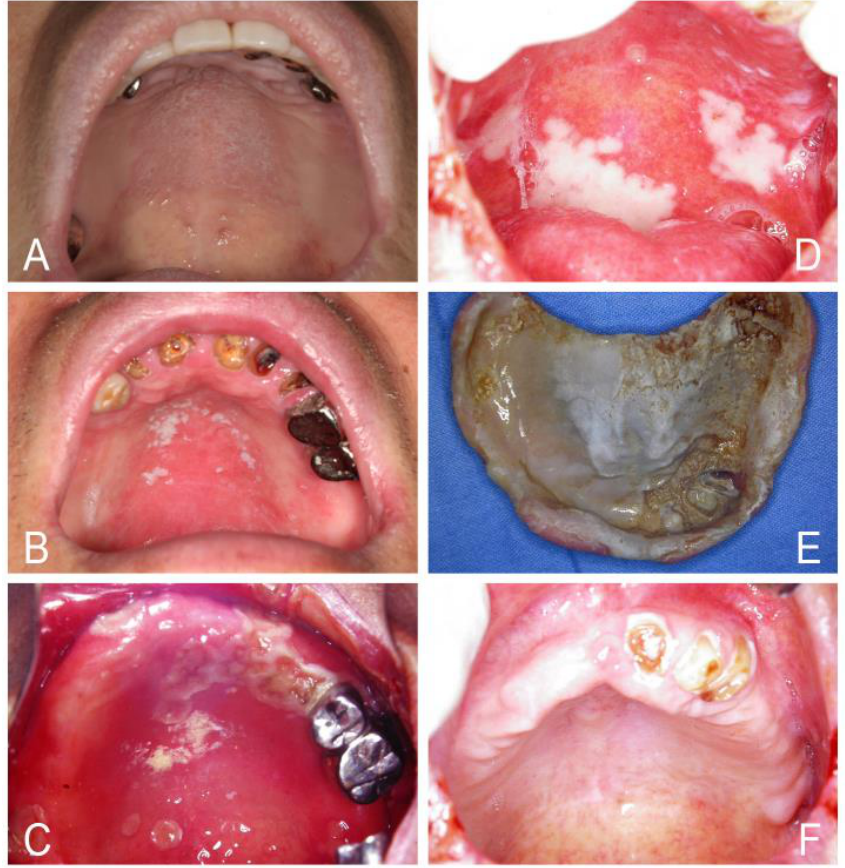
Figure 4. Candida -associated denture stomatitis ( A – D ) showing a more diffuse erythema involving a part or the entire denture-covered mucosa combined with pseudomembranous candidosis and angular cheilitis in four people who wore dentures for many years. An ill-fitting denture ( E ) showed poor denture hygiene and the denture-relining materials acted as a chronic reservoir allowing continuous seeding of Candida onto the palatal tissue of the patient ( D ). Complete resolution of denture stomatitis after antifungal therapy with nystatin tablets, efficient oral and denture hygiene and removal of the denture ( F ).